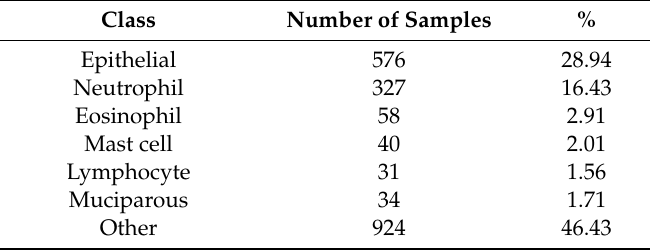
Table 2. Class distribution in dataset